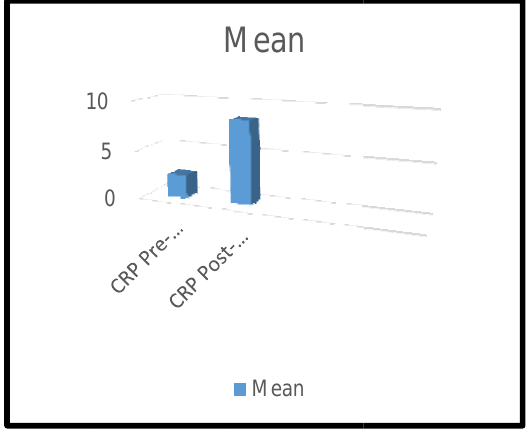
Figure 11: pre- and post he level of CRP at the 2nd day was higher than the level of CRP at the day of surgery (pre